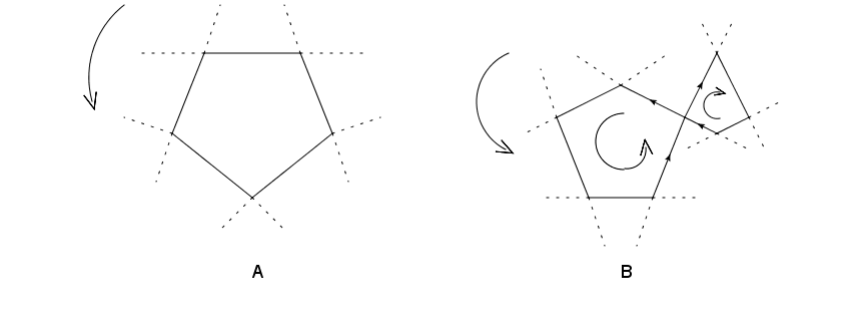
Figure 2 . The pilot process shows two properties of e(cid:11)ective Feynman diagram.